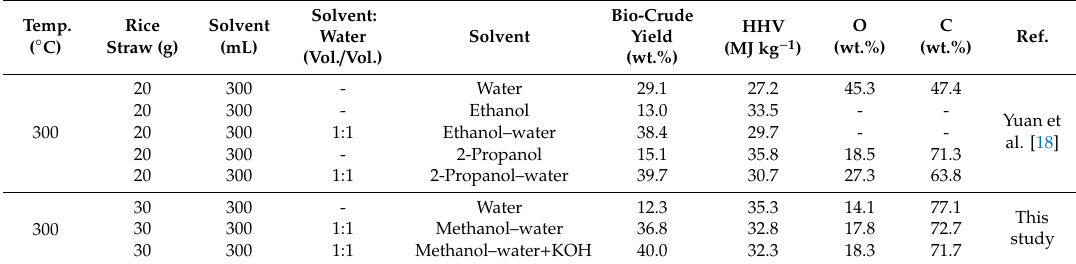
Table 5. Comparison of bio-crude yield and its properties reported in the literature with this study. Temp. ( ◦